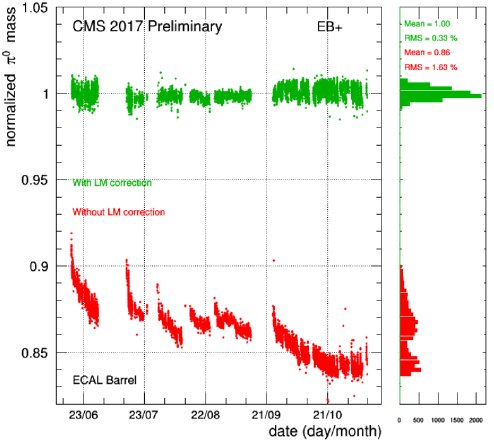
Figure 1. Time evolution of the ECAL energy scale measured from the invariant mass distribution of π 0 → γγ decays in the barrel. The energy scale is measured by fitting the invariant mass distribution of approximately 500k photon pairs in the mass range of the π 0 meson. Each point corresponds to approximately 5 minutes of data-taking. Data with (green dots) and without (red dots) the applications of the laser monitoring corrections are shown. The right-hand panel shows the projected relative energy